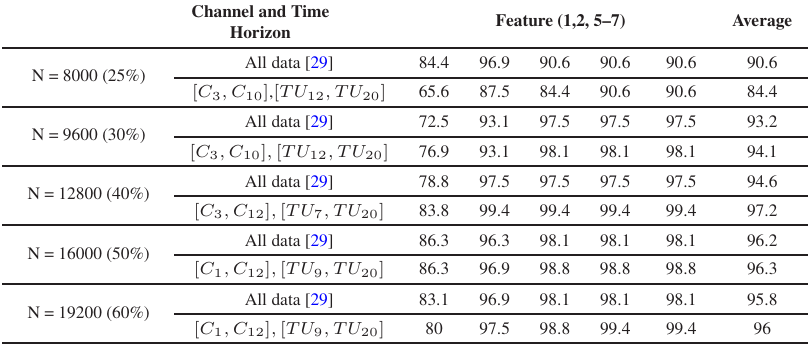
Table 2. Each classification rate from the five-fold cross-validation for selected channels and time-horizon